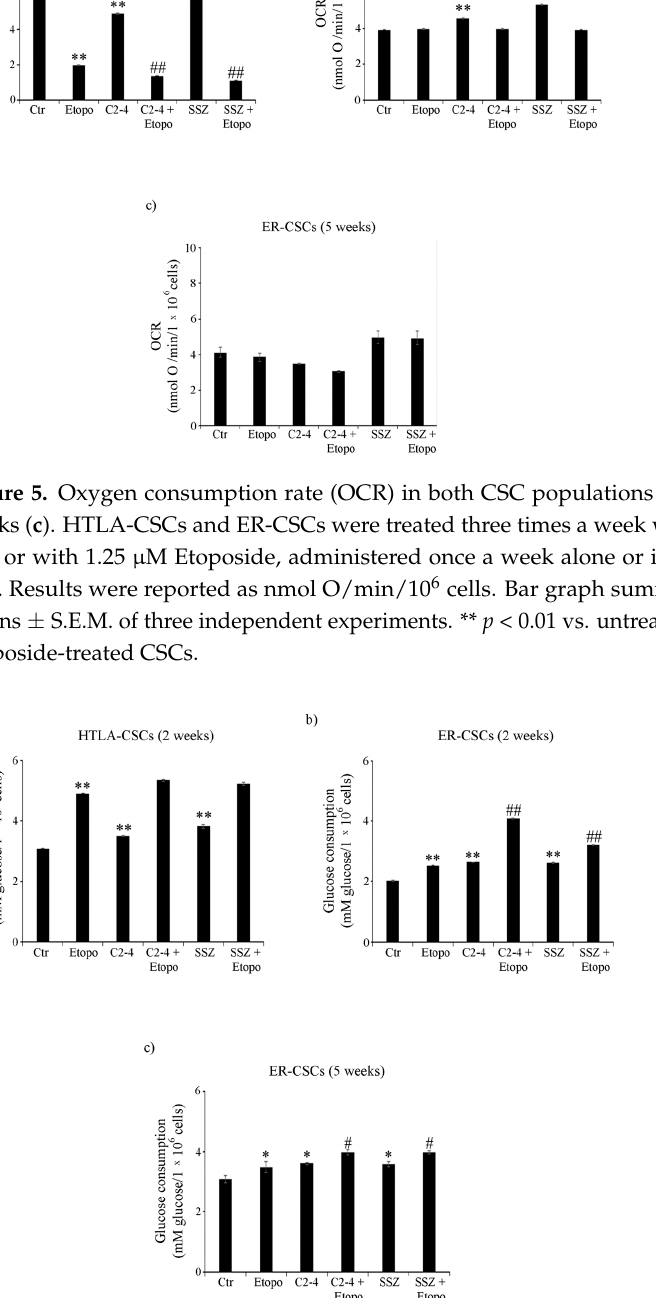
Figure 6. Glucose consumption in both CSC populations treated for two ( a , b ) or five weeks ( c ). HTLA-CSCs and ER-CSCs were treated three times a week with 0.1 µM C2-4, with 5 µM SSZ or with 1.25 µM Etoposide, administered once a week alone or in